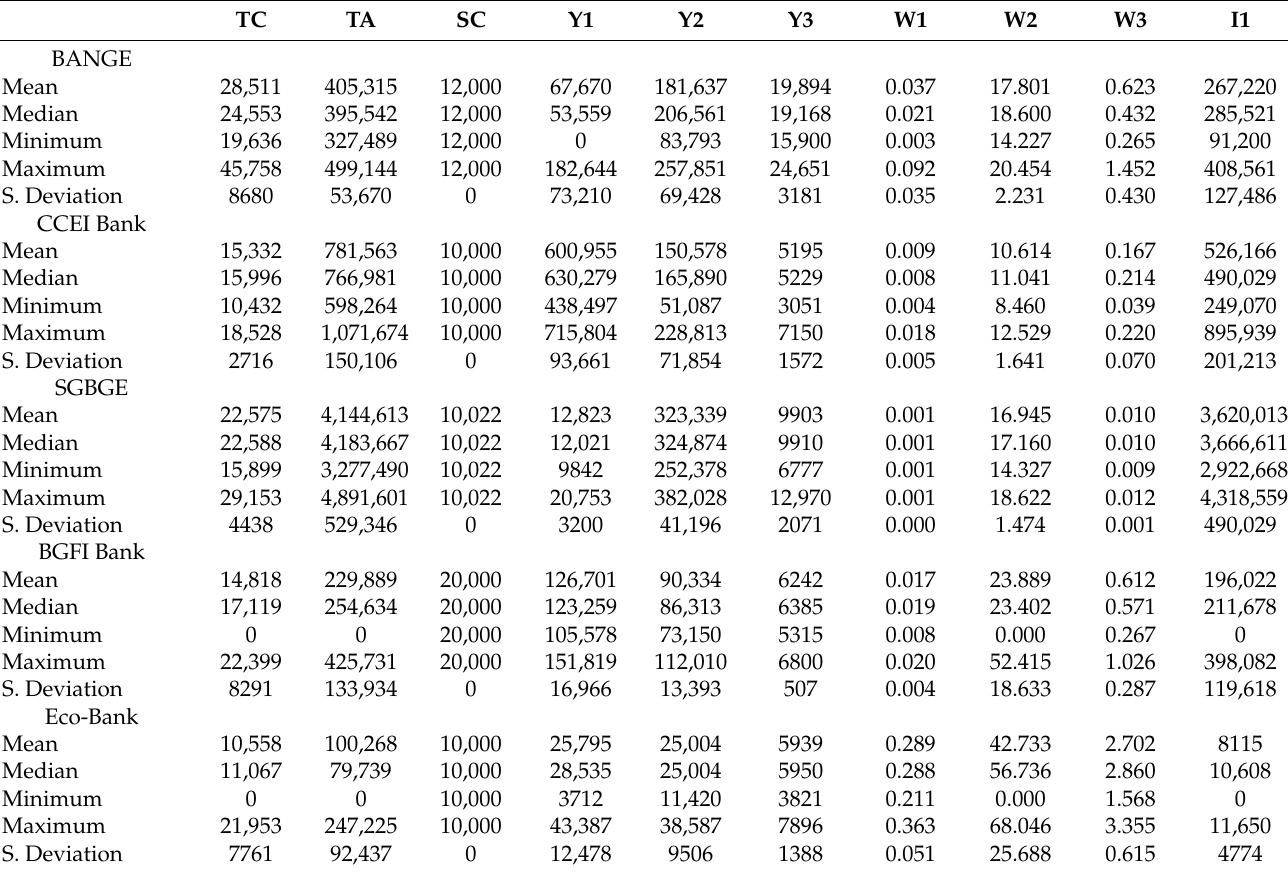
Table 4. Descriptive Statistics: total costs, outputs and input prices 2010–2019 (M